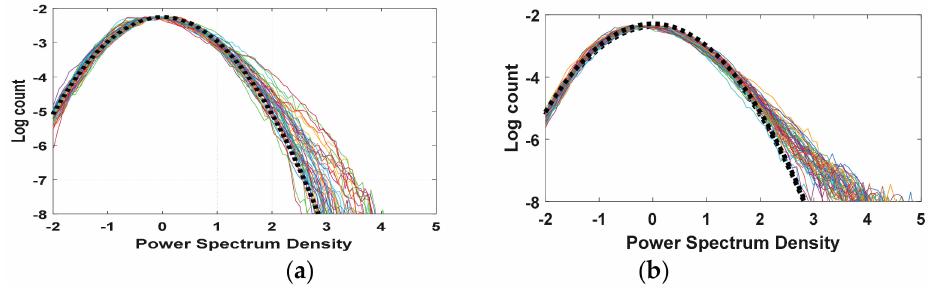
Figure 9. Example of histograms where RFI can be identified only by KL divergence ( a ); and of RFI that can be identified by Fisher Z test ( b